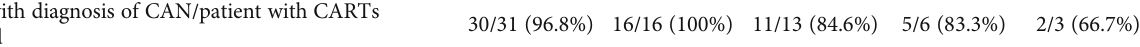
0 (0%) † Patients with diagnosis of CAN/patient with CARTs 30/31 (96.8%) 16/16 (100%) 11/13 (84.6%) 5/6 (83.3%) 2/3 (66.7%) performed SPK: simultaneous pancreas and kidney transplantation; BMI: body mass index; eGFR: estimated Glomerular Filtration Rate; HDL-C: high-density lipoprotein cholesterol; LDL-C: low-density lipoprotein cholesterol; CAN: cardiovascular autonomic neuropathy. † p < 0 : 001 , patients at 3, 5, 7, or 10 years after SPK vs baseline. # p < 0 : 01 , patients at 3, 5, 7, or 10 years after SPK vs baseline. ¤ p < 0 : 05 , patients at 3, 5, 7, or 10 years after SPK vs baseline. nd: test not